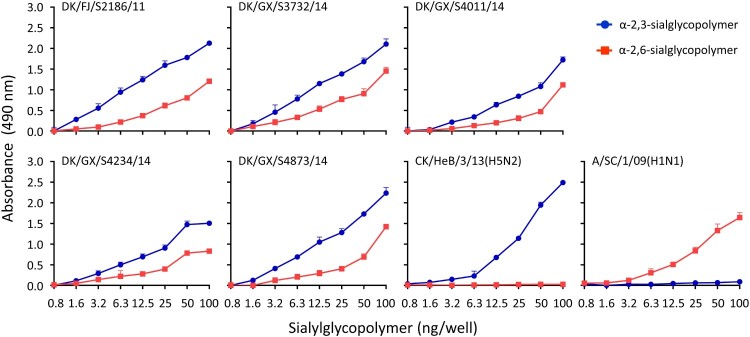
Receptor-binding properties of H3N2 avian influenza viruses. The binding of the H3N2 viruses to two different glycans (α-2,3-glycans, blue; α-2,6-glycans, red) was tested. Two viruses, CK/Hebei/3/13 (H5N2) and Sichuan/1/09 (H1N1), that bind to α-2,3- and α-2,6-glycans, respectively, were used as controls. The data shown are the means of three repeats, the error bars indicate standard deviations.